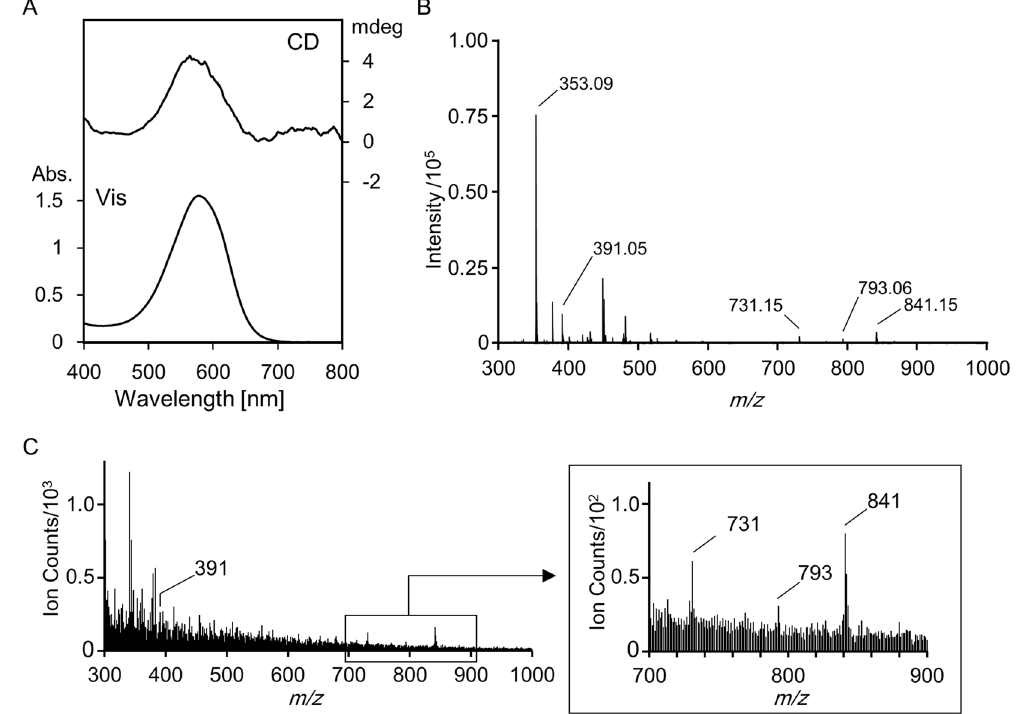
H 2 O. ( B ) ESI-TOF MS spectrum of the hydrangea blue-complex conducted in negative detection mode. ( C ) Cryo-TOF-SIMS spectrum of hydrangea blue-complex conducted in negative detection